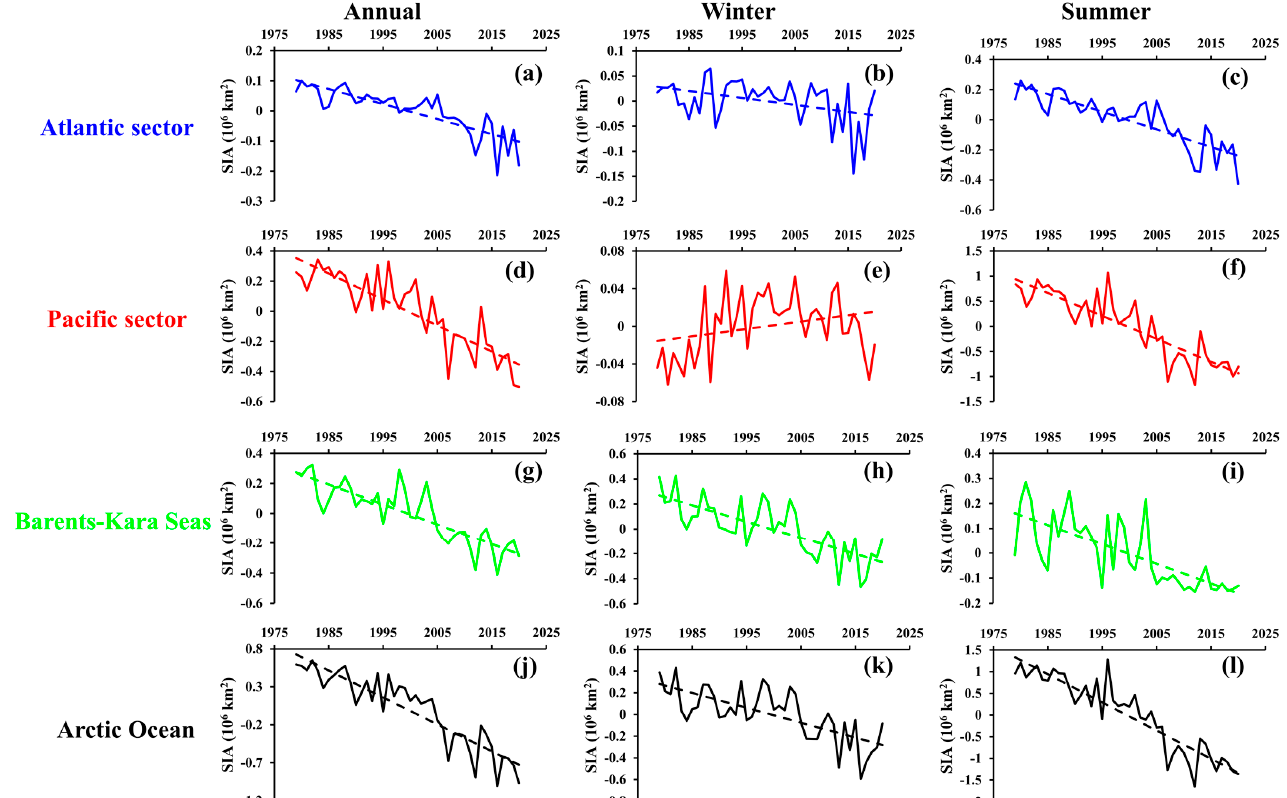
Figure 4. The annual and seasonal time series of sea ice area (SIA) anomalies in 1979–2020 for the Atlantic sector ( a – c ), Pacific sector ( d – f ), Barents–Kara Seas ( g – i ) and the Arctic Ocean ( j – l ). The serious decrease in SIA mainly occurred in the low latitude regions in Figure 5.